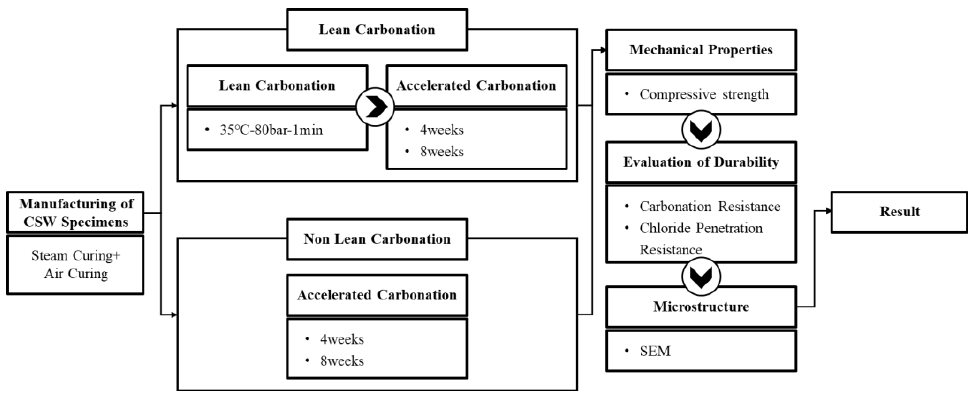
Figure 1. Research flow of this study.